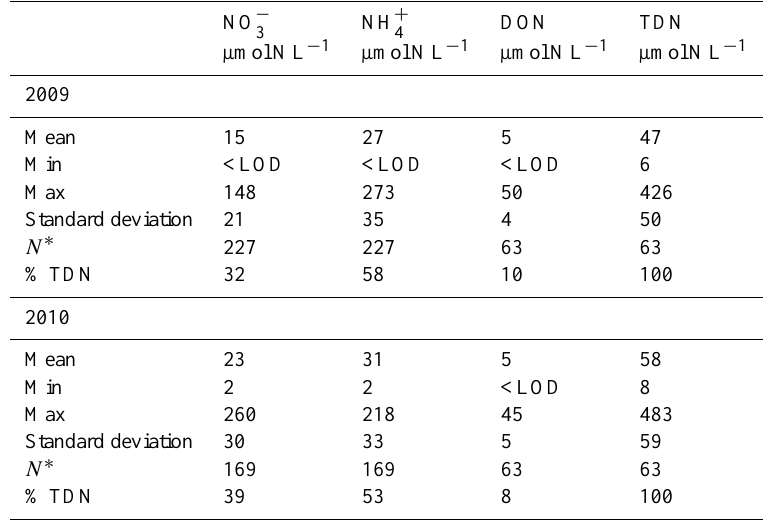
Table 1. Statistics of annual concentrations of NH + individual samples collected over the 2-year period. N ∗ indicates the number of samples collected.